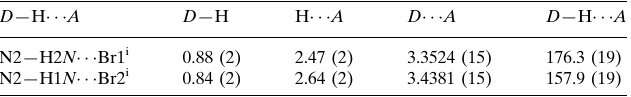
Data collection Bruker APEXI CCD diffractometer Absorption correction: multi-scan ( SADABS ; Sheldrick, 2008 b ) T